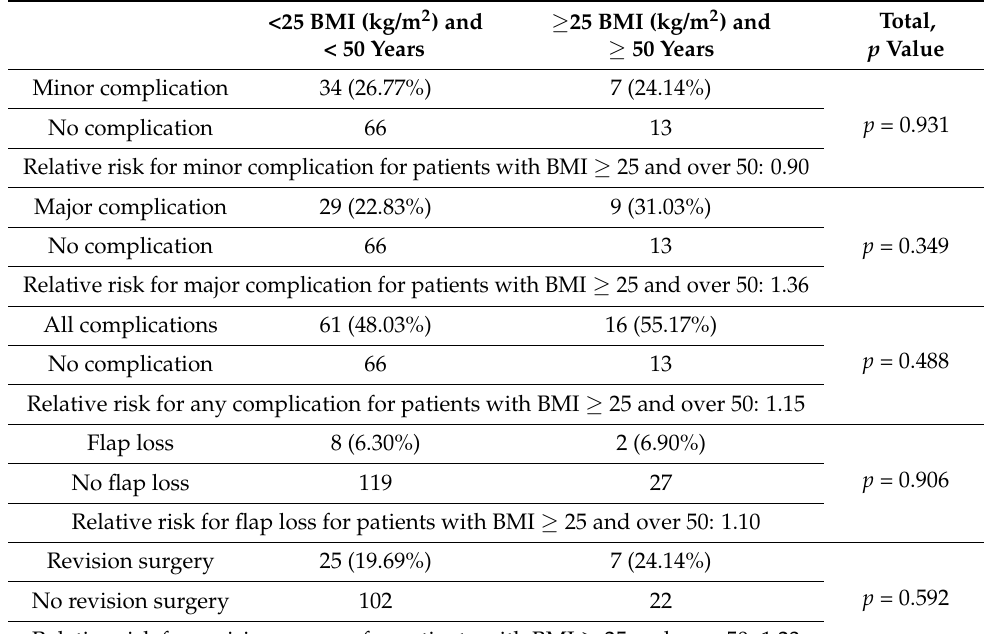
Table 4. Complications were also categorized according to patient BMI (over and below BMI of 25). <25 BMI (kg/m 2 ) ≥ 25 BMI (kg/m 2 ) Total, p Value Minor complication 56 (24.24%) 14 (20.29%) Relative risk for minor complication for patients with BMI ≥ 25: 0.84 Major complication 61 (26.41%) 22 (31.88%) Relative risk for major complication for patients with BMI ≥ 25: 1.21 All complications 112 (48.48%) 35 (50.72%) Relative risk for any complication for patients with BMI ≥ 25: 1.05 Flap loss 14 (6.06%) 5 (7.25%) Relative risk for flap loss for patients with BMI ≥ 25: 1.20 Revision surgery 54 (23.38%) 18 (26.09%) Relative risk for revision surgery for patients with BMI ≥ 25: 1.12